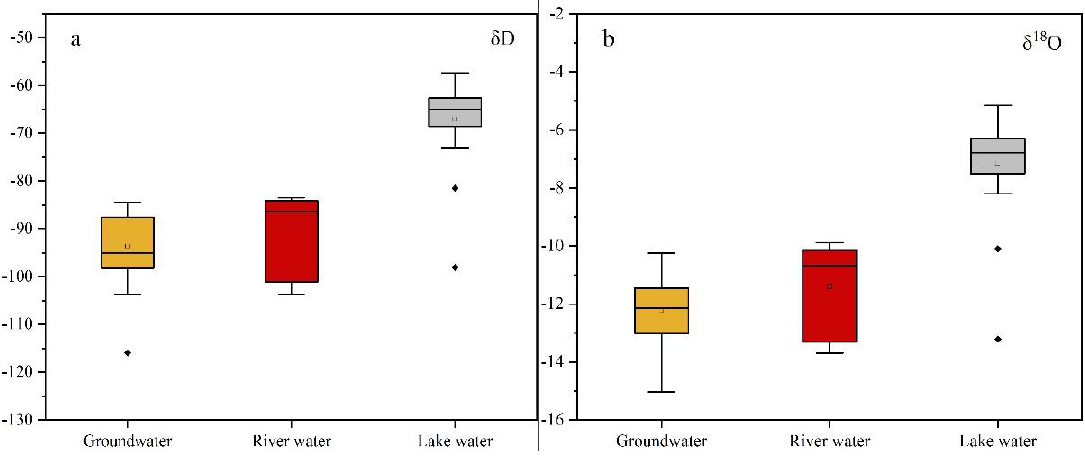
Figure 5. δ D and δ 18 O for the water in the Hulun Lake Figure 5. δD and δ 18 O for the water in the Hulun Lake regime. Figure 5. δD and δ 18 O for the water in the Hulun Lake regime.